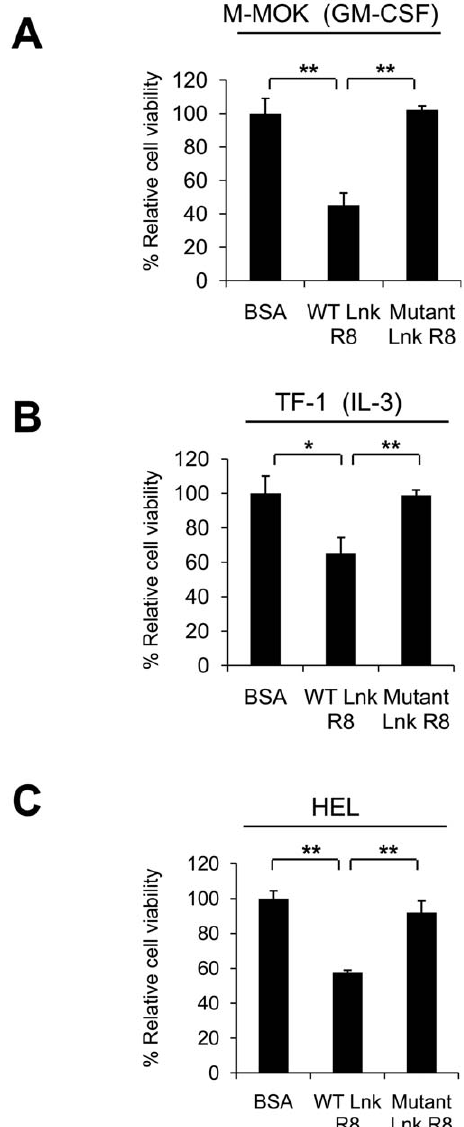
Figure 8. WT Lnk R8 inhibits Jak2-dependent cell proliferation. (A) M-MOK, (B) TF-1 or (C) HEL cells were pre-treated with the 5 m M of WT, mutant Lnk R8 or BSA. After treatment, cytokines GM-CSF and IL-3 were added into culture medium of M-MOK and TF-1, respectively. Cell viability was measured by performing MTT assays after 2 days. (Data represent mean 6 SD and results are representative of three independent experiments, *p , 0.05 , **p , 0.01 ).